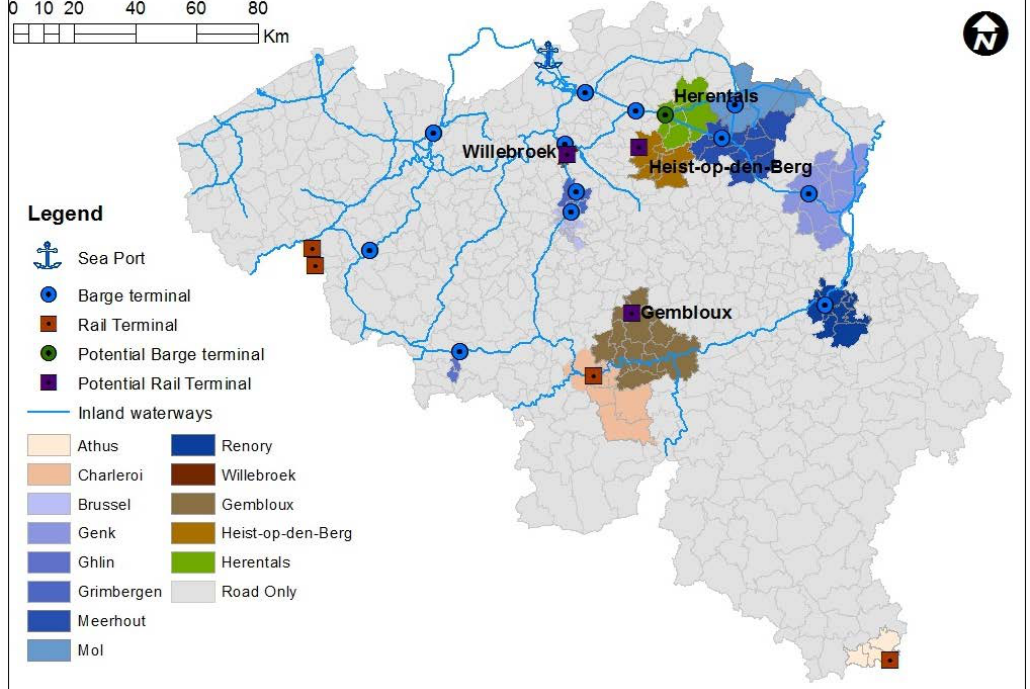
Figure 7. The four potential terminal locations in Belgium with the highest potential transhipment volumes when VOT is considered as a modal choice